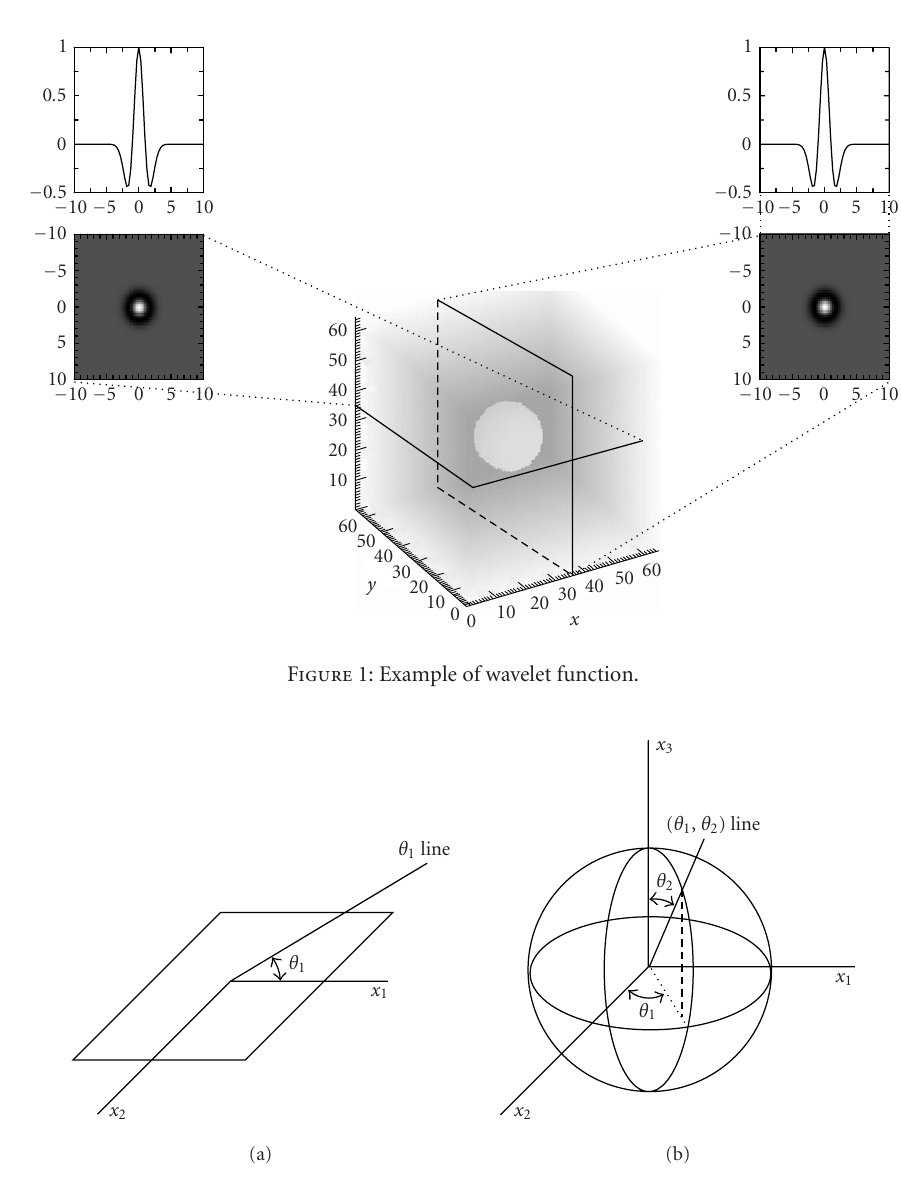
Figure 2: Definition of angle1 θ 1 and θ 2 in (a) R 2 (2D case) and (b) R 3 (3D